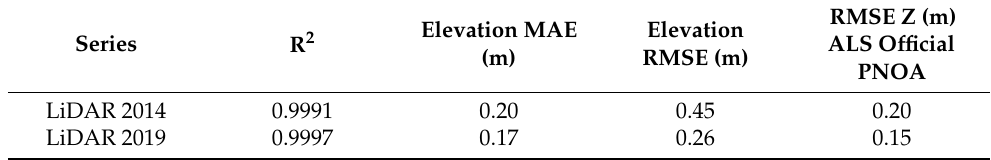
Table 1. LiDAR-ALS-derived DSM accuracy assessments regarding GNSS measurements.